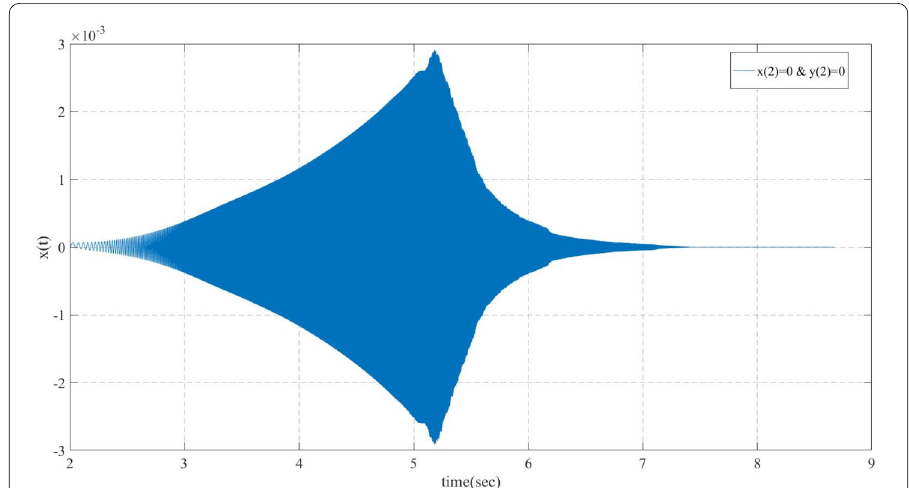
Figure 1 Trajectory of x ( t ) for Example 1 when x (2) = 0 and y (2) = 0